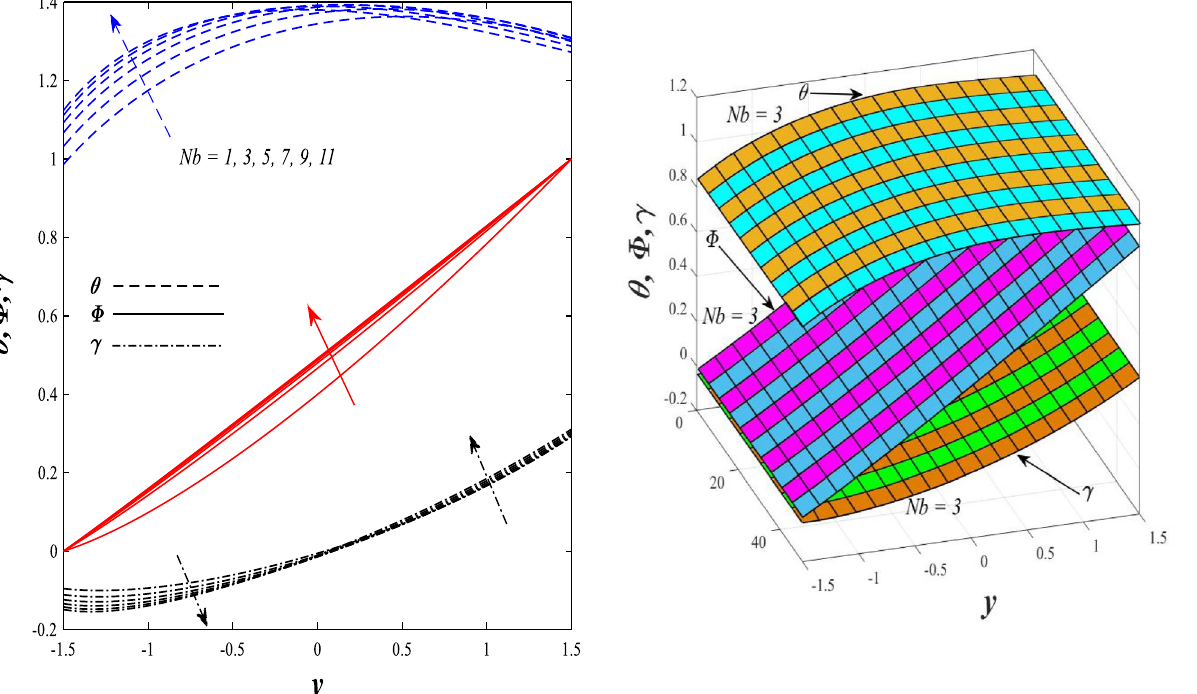
Figure 13. Effect of Brownian motion parameter Nb on the distributions of both temperature, solutal concentration and nanoparticles volume fraction 2D and